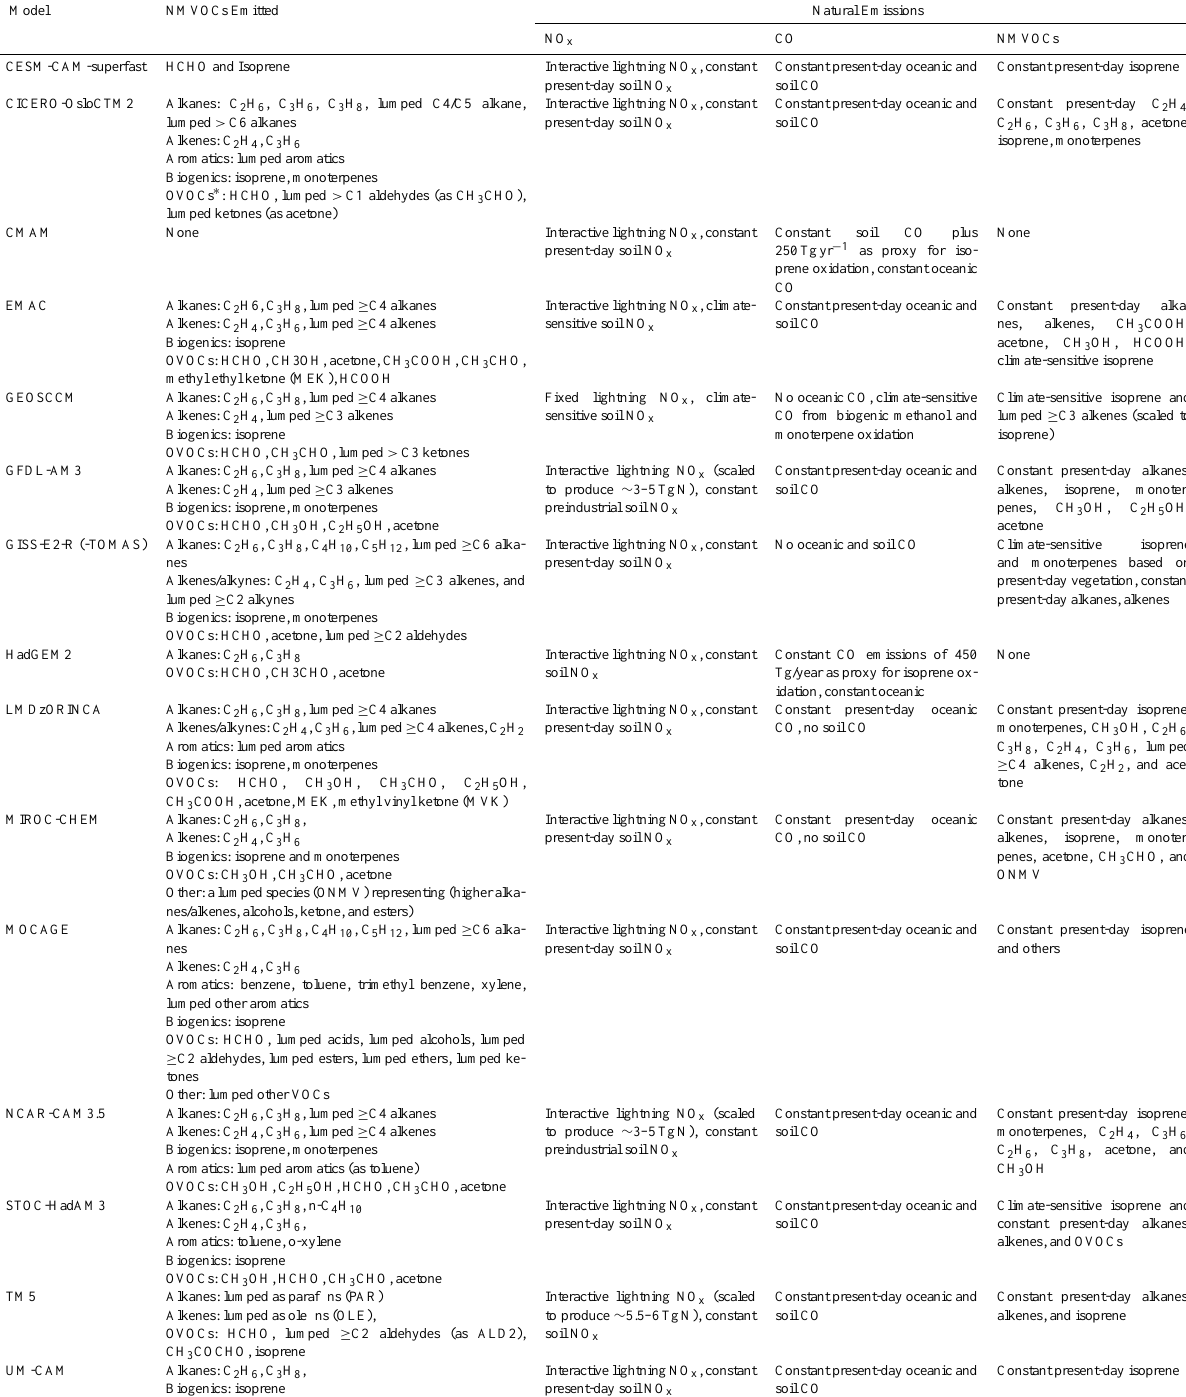
Table A1. Summary of NMVOCs emitted and natural emissions considered in the models. Model NMVOCs Emitted Natural Emissions CESM-CAM-superfast HCHO and Isoprene InteractivelightningNO x ,constant